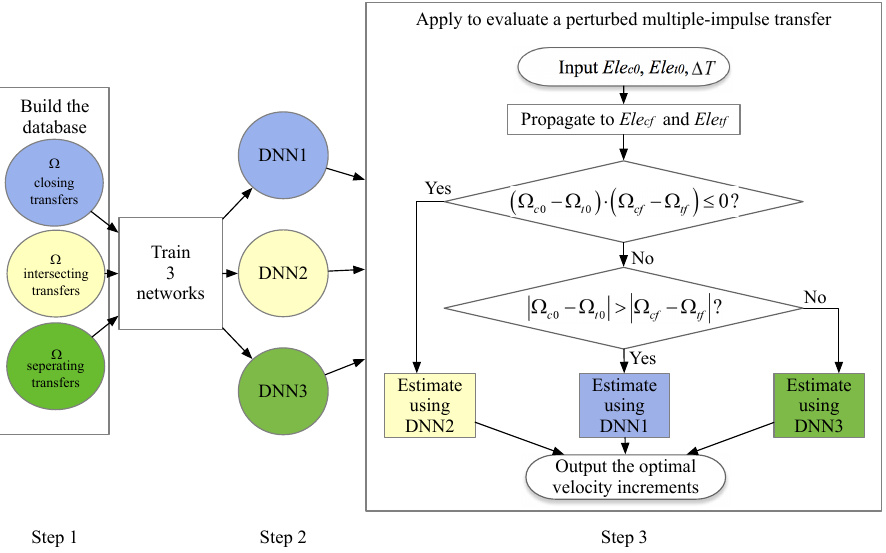
Figure 6. Solving framework of the estimation methods for perturbed multiple-impulse